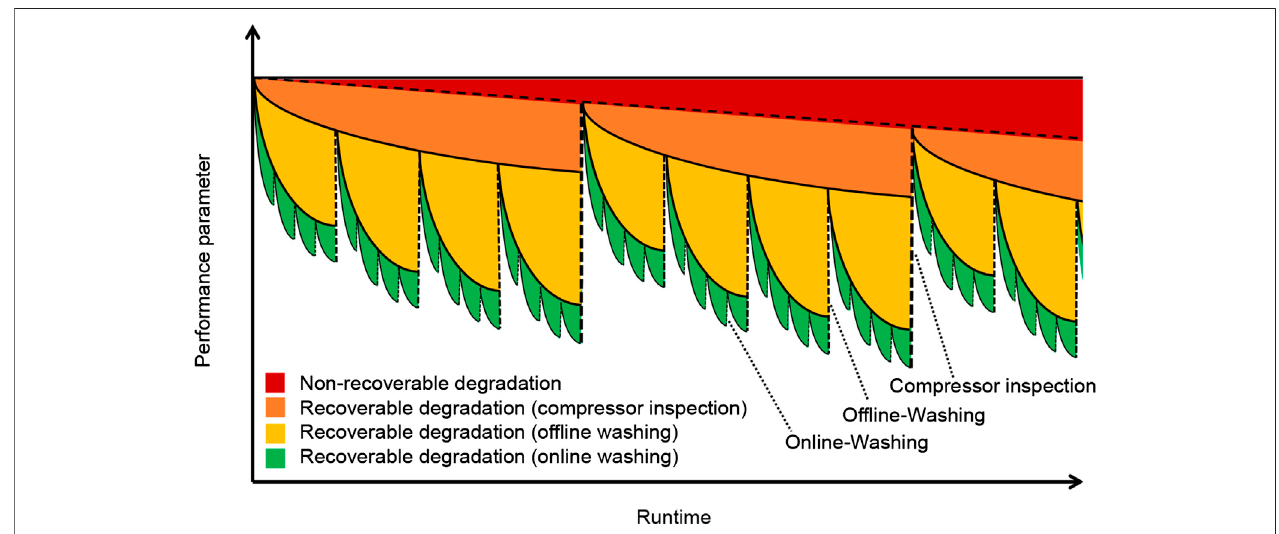
FIGURE 3 | Example of the different types of degradation in a compressor and different types of maintenance to restore ef fi ciency.